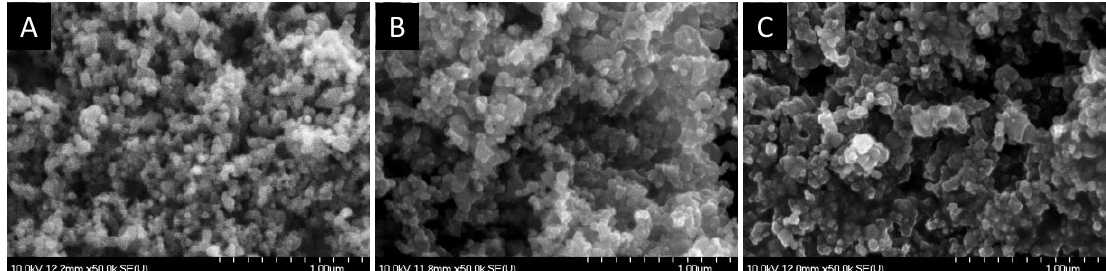
Figure 8. Scanning electron microscopy (SEM) images, taken for ( A ) SiC; ( B ) SiC/PANI UV-irradiated sample (60 min); ( C ) SiC/PANI UV-filtered sample (60 min).